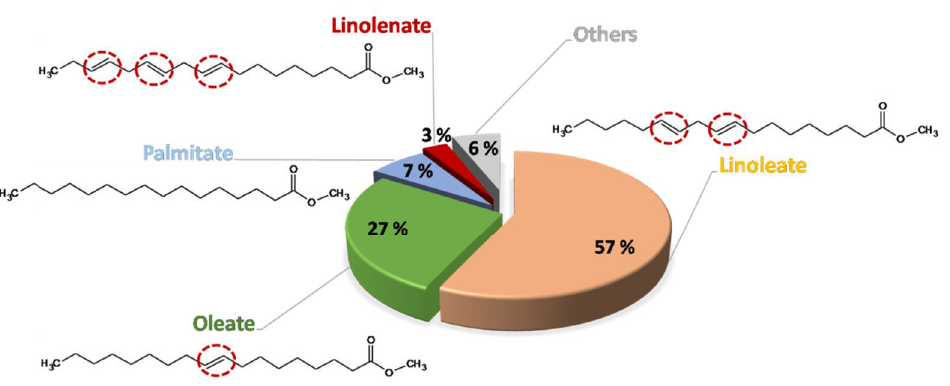
Figure 2. Fatty acid methyl ester profile of frying oil biodiesel (FOBD). Double bonds are circled in red.